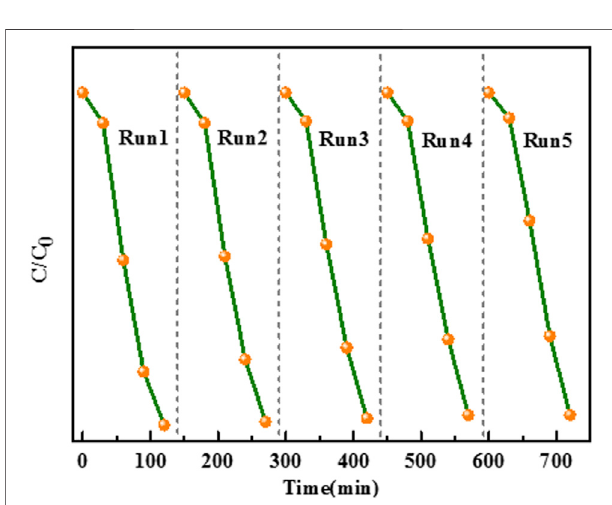
FIGURE 11 | The stability of 0.2CD-TNs for Congo red